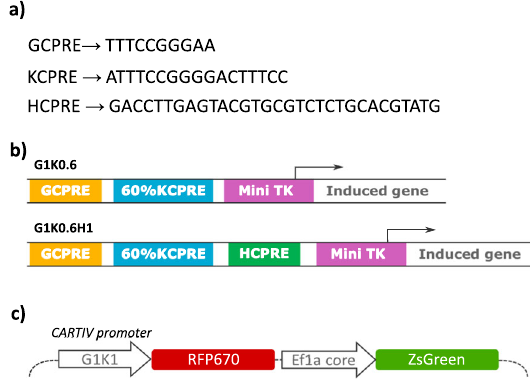
Fig. 1 The promotor response elements used to construct the CARTIV promotes and the vector used. a CARTIV promotor response elements (CPREs) used in CARTIV promotors. b Two of the tested promotors. Yellow: IFN γ CPRE (GCPRE), turquoise: NFkB CPRE (KCPRE), green: hypoxia CPRE (HCPRE), purple: minimal herpes simplex virus thymidine kinase (Mini TK). c The vector used in the CARTIV system. Direct activation of the CARTIV vector, including an independent constitutive